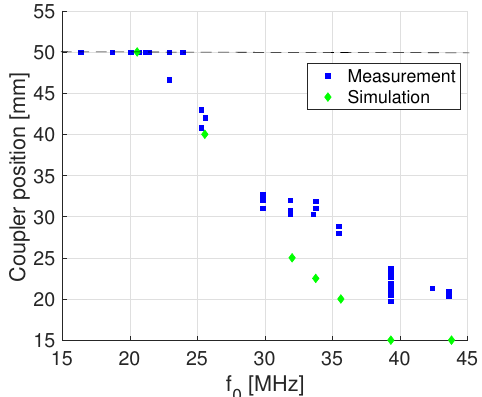
Figure 8. Impedance matching condition for various resonant frequencies: absolute best coupler position found with the model (green dots), and coupler position used during twenty-five years of machine operation (blue dots). The dashed black line highlights the maximum limit of the coupler